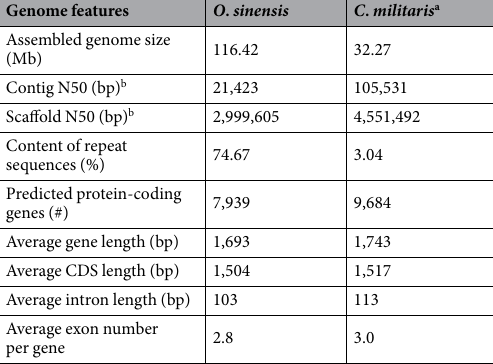
Table 1. Comparison of genome features between O . sinensis and C . militaris . a From Zheng et al . Genome Biology 2011, 12:R116; b N50 values of the genome assemblies were calculated using the fragments ≥ 1